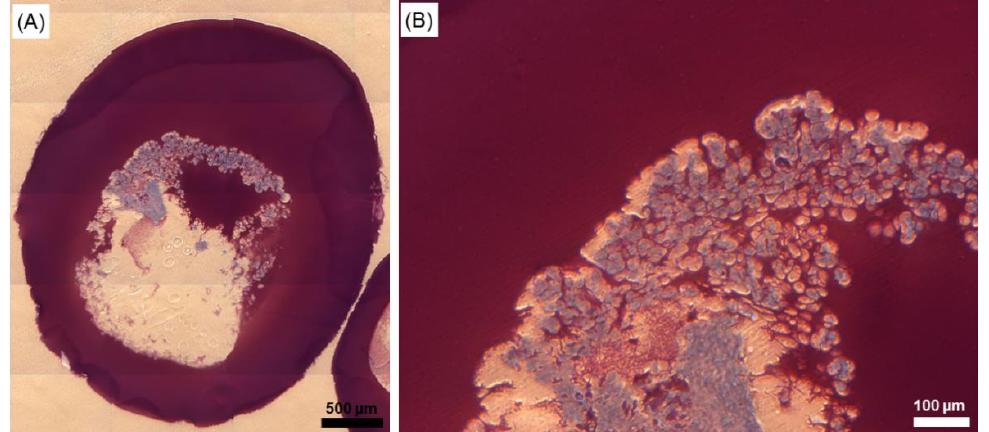
Figure 7. Toluidine blue staining profile of cellular networks within core-shell capsules after 35 days of culture. Picture ( B ) represents a higher magnification of ( A ). Cellular structures are shown in blue whereas the shell of an exemplary core-shell capsule is stained in red-purple. Scale bars are 500 µm ( A ) and 100 µm ( B ).